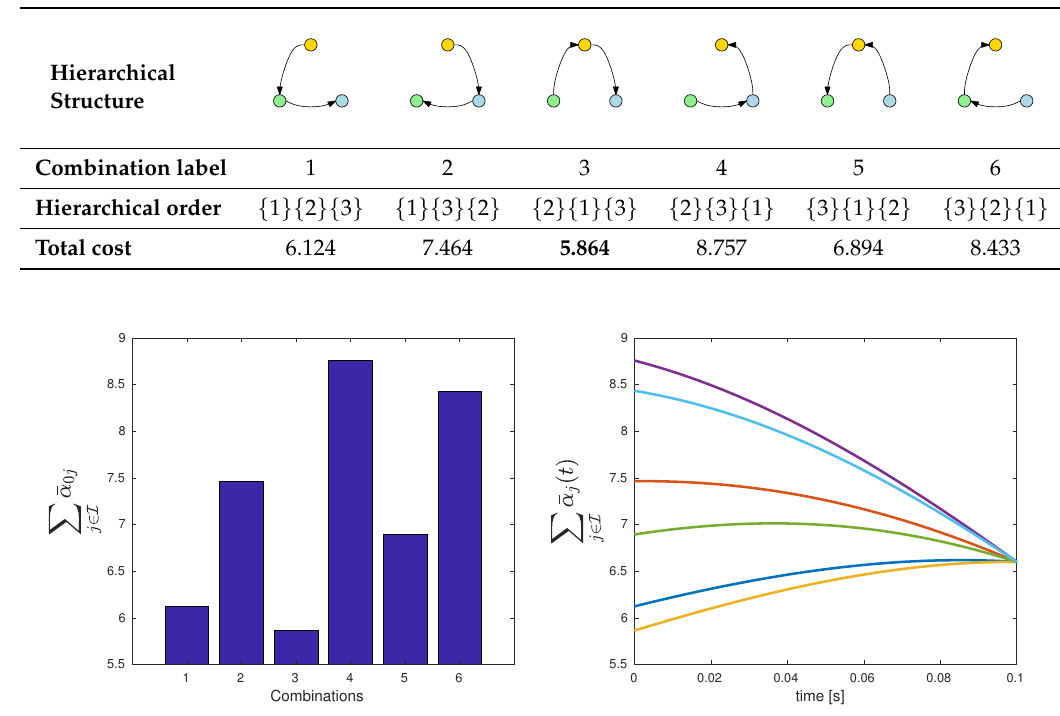
Table 3. Total cost for the different hierarchical orders in a three-player case in the heterogeneous scenario. bold—significant difference.